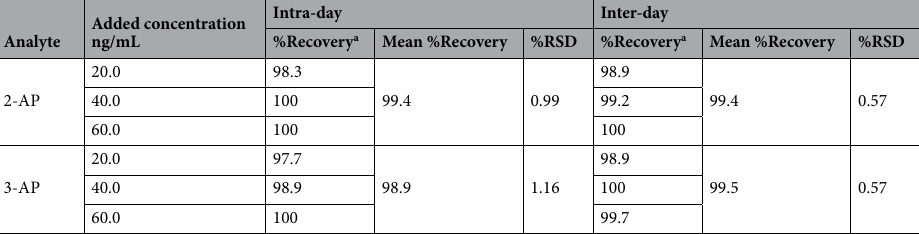
Table 3. Evaluation of accuracy and precision of the proposed analytical method. a Each result is the average of 3 different determinations.